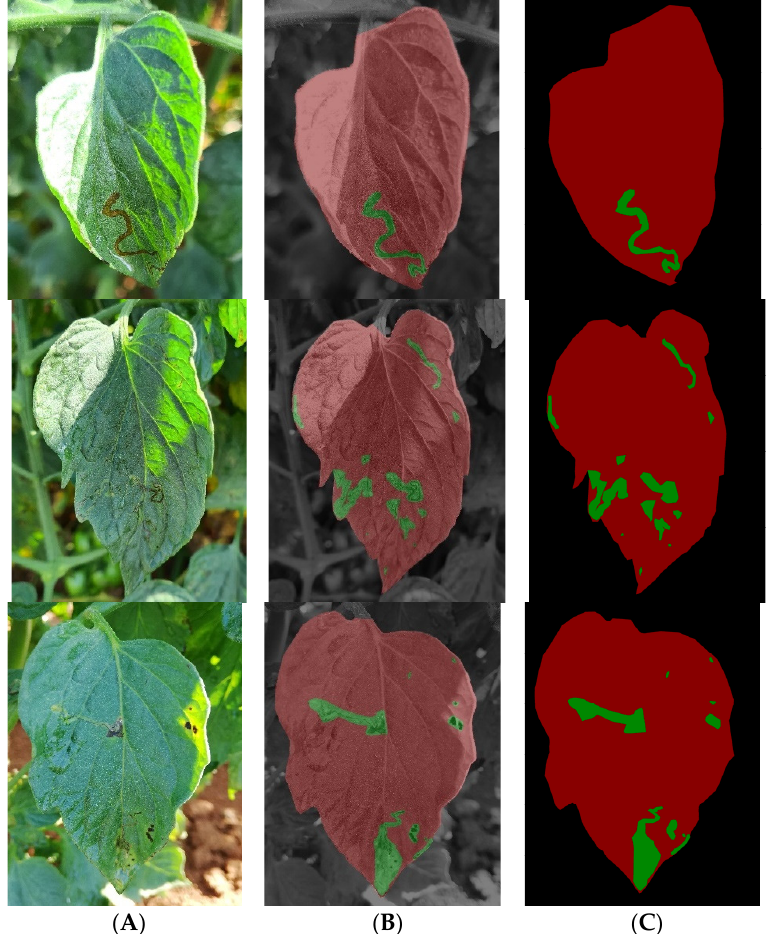
Figure 1. Examples of ( A ) the original image, ( B ) polygons manually generated from regions of interest, and ( C ) results of the reference masks with the three annotated classes. The background is black, the leaf of interest is red, and pest symptom is green.